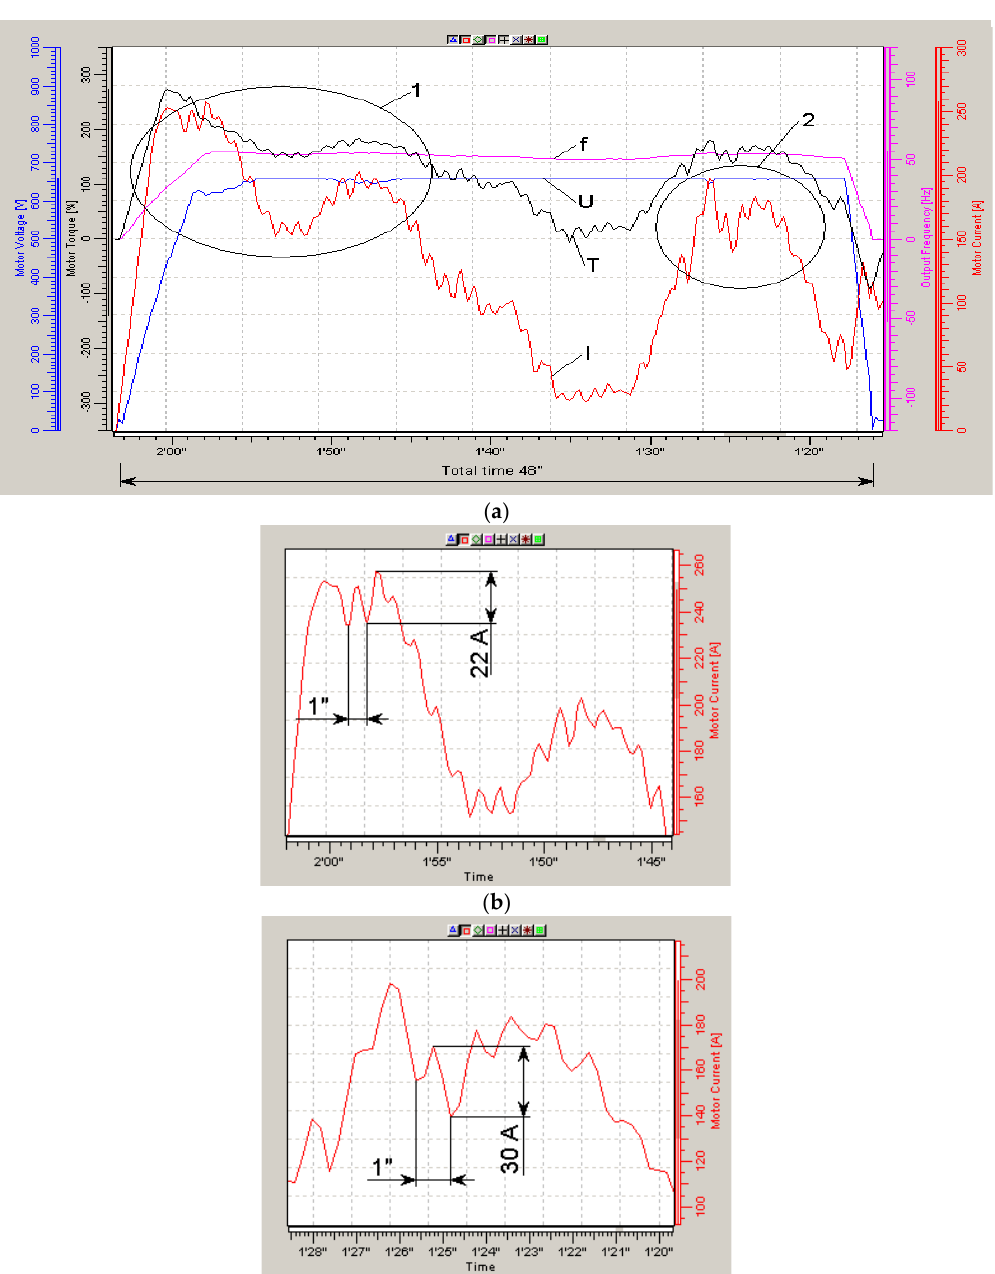
Figure 7. Diagrams of movement at high speed along track 3 with parameters U = 660 V, f = 50–55 Hz and U/f = 16 Fl ( a ) and extended sections 1 ( b ) and 2 ( c ) of the current